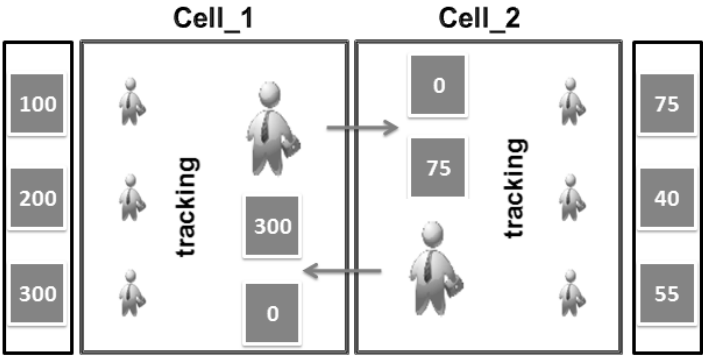
Figure 6. Resetting global reputation of moving Leader.